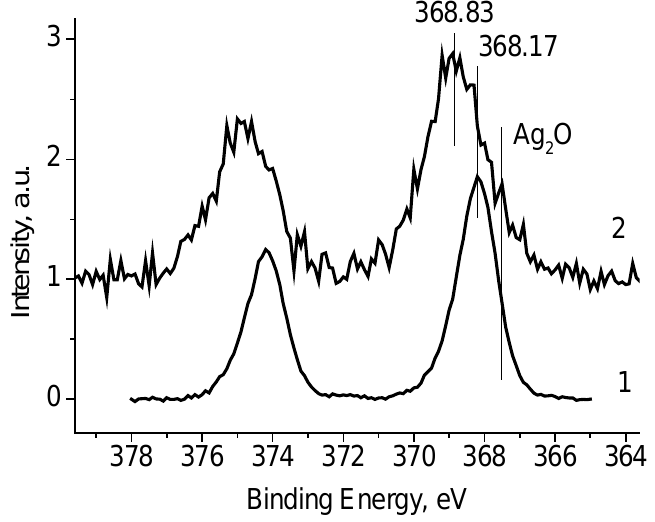
Figure 11. The C 1s photoelectron spectra of Ag black (1) and Ag/bandage system (2).